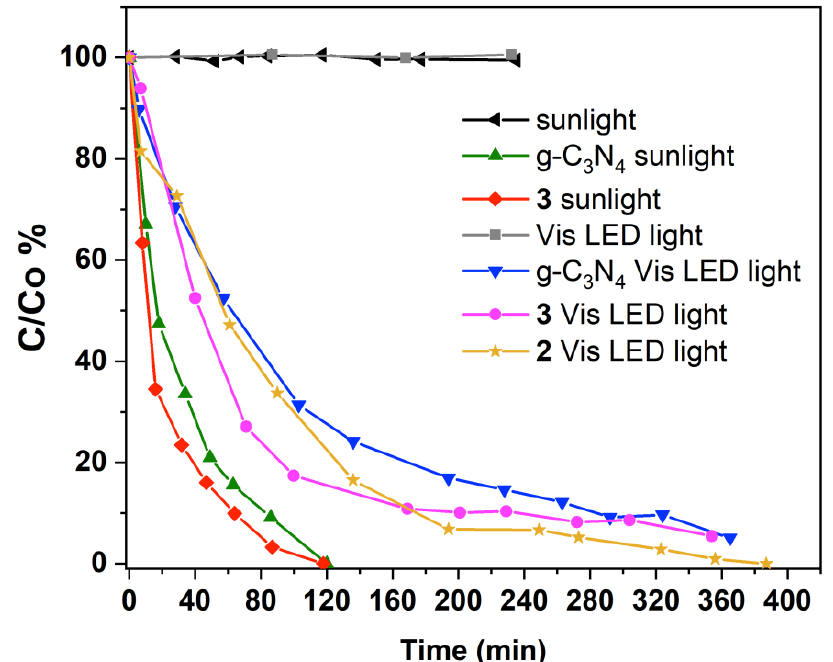
Figure 8. Evolution of ibuprofen concentration during its degradation with g-C 3 N 4 and nanohybrids 2 and 3 , under visible LED light or under sunlight.